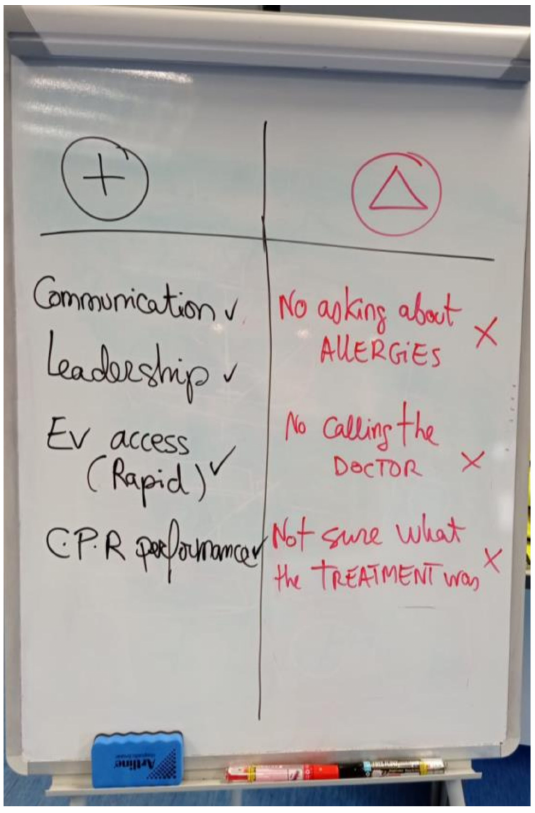
Figure 1. Example of graphical representation of strengths/weaknesses